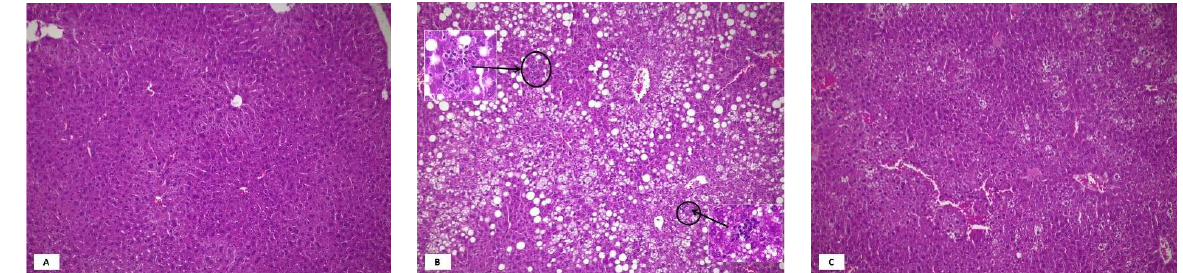
Figure 1. Representative pictures of liver hematoxylin-eosin staining in the three groups. Normal liver histology in mice fed standard diet (Panel ( A ), original magnification 10×). Mice on HFD for 12 weeks showed severe mixed, micro- and macrovesicular steatosis (Panel ( B ), original magnification 10×). Two necro-inflammatory foci are visible in this field (Orig- inal magnification in the inserts 40×). Amelioration of liver histology in mice fed high fat diet + decaffeinated coffee for 12 weeks: absence of macrovesicular steatosis and inflammatory foci, reduction of microvescicular steatosis (Panel ( C ), orig- inal magnification 10×).